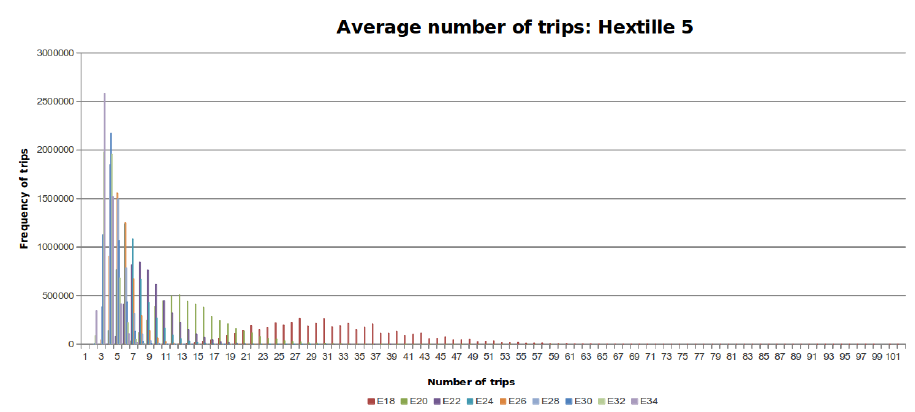
Figure 12. DFG G 5 with the variation of the required number of steps (cid:101) h for the 5,000,000 flights. The average number of trips for G 5 with (cid:101) h is 33 trips with a frequency between 200,000 and 300,000 flights to explore the whole DFG. If the number of steps is incremented, the average number of flights reduces.